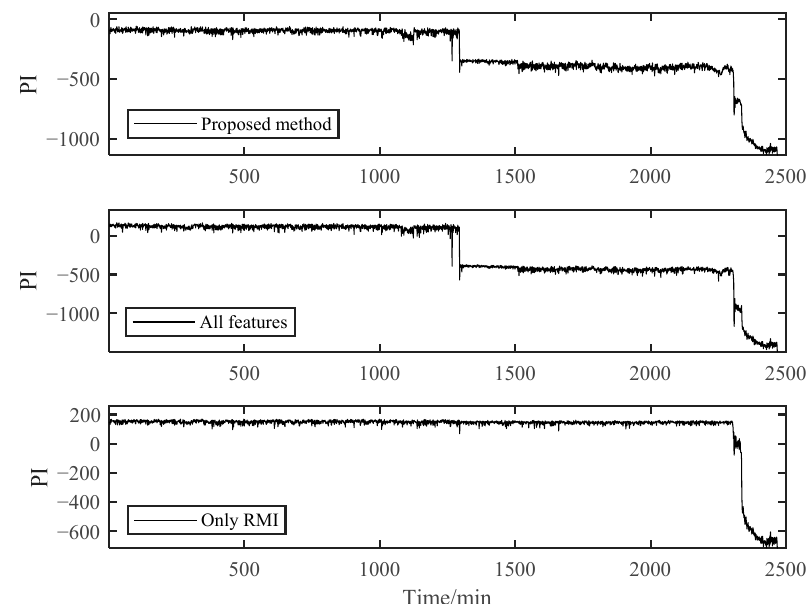
Figure 17. Comparison of three different methods of B1.